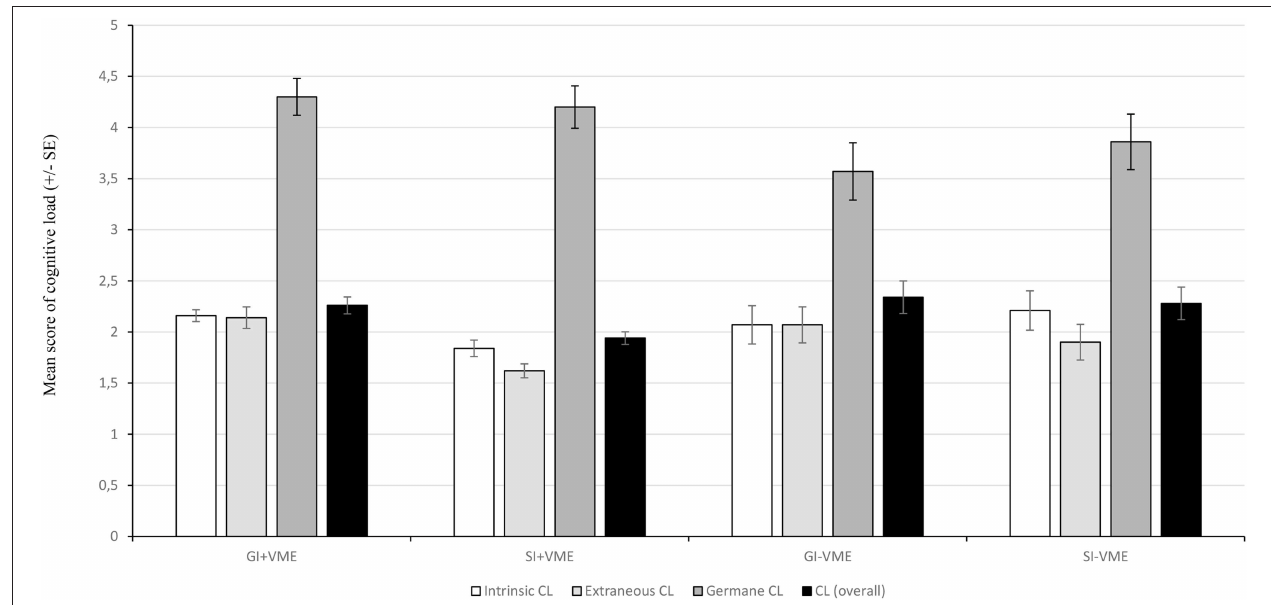
FIGURE 3 | Mean score of (intrinsic, extraneous, germane, overall) cognitive load by treatment (GI + VME, SI + VME, GI-VME,